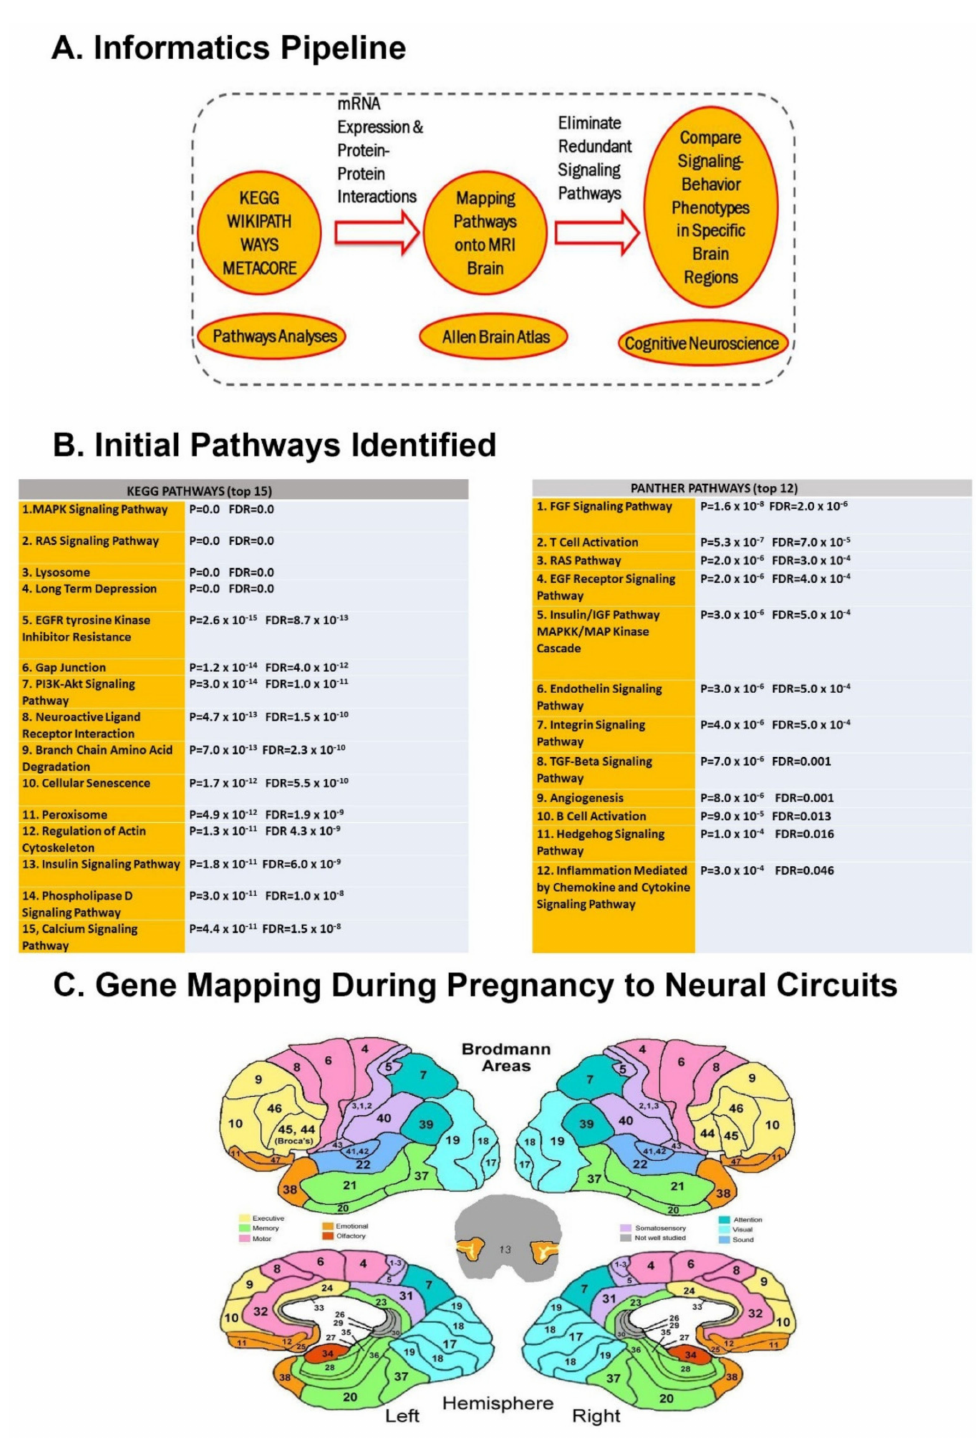
Figure 1. Informatics Pipeline and Mapping of Genes to Neural Circuits: ( A ) Schemati represen- tation of the informatic pipeline analysis ( B ) 2631 neurodevelopmental genes, including 594 from pathogenic CNVs of autism subjects, were analyzed via KEGG and Panther pathway analysesPromi- nent signaling pathways which use MAPK, RAS, and tyrosine receptor kinases were common to both analyses. ( C ) After protein–protein interactions were evaluated via String and mRNA Co-expression analyses, 121 genes were mapped for their antenatal/postnatal expression in Research Domain Criteria (RDoC)-defined neural circuits using Brodmann